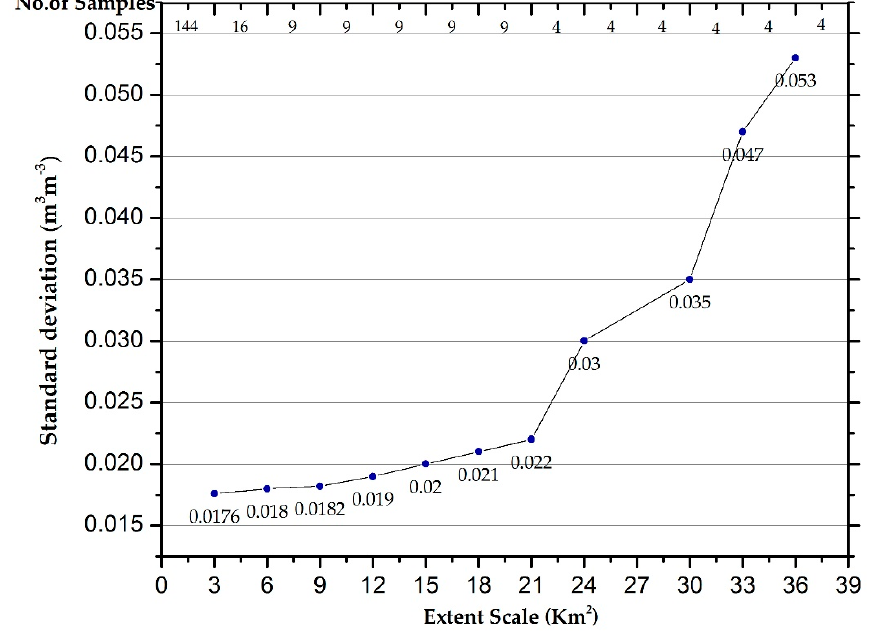
Figure 7. Standard deviation of soil moisture samples obtained within sampling extents ranging from 3 km 2 to 36 km 2 during intensive field campaign. The number of samples is shown on the top of the x -axis.